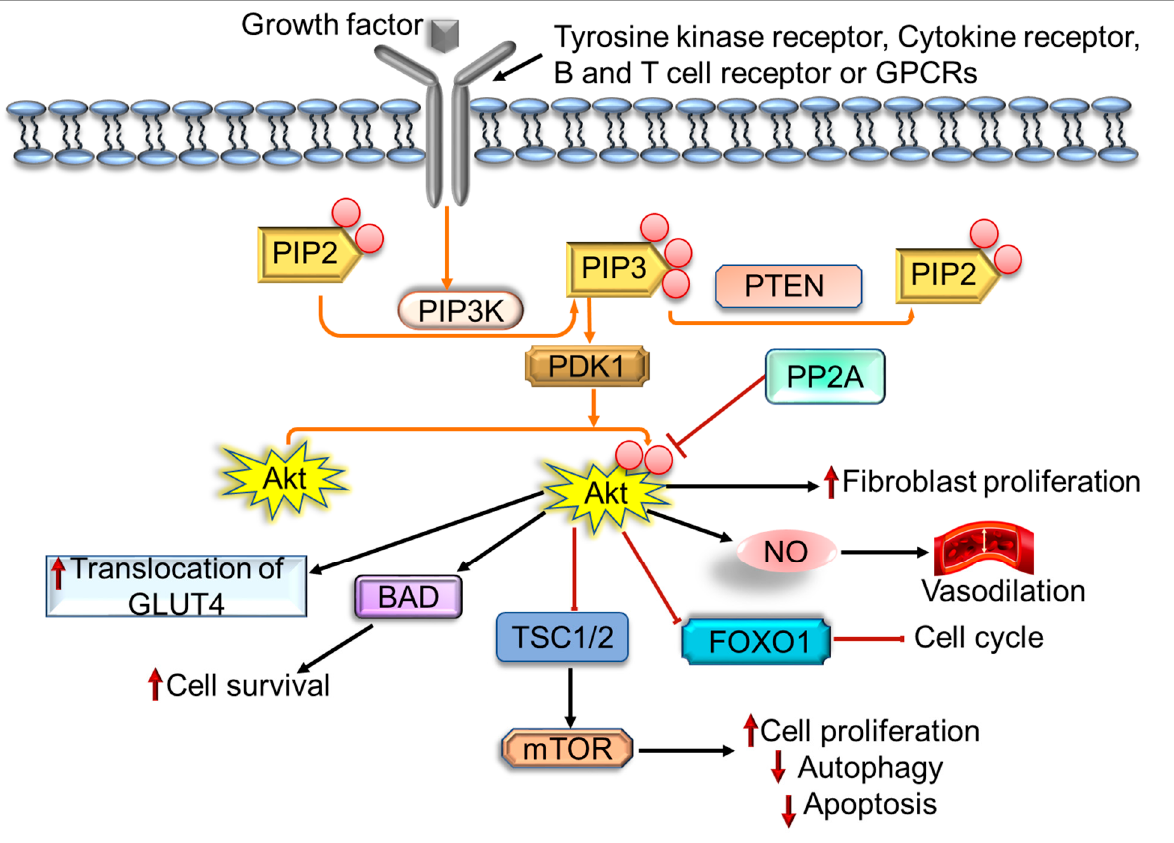
Figure 2. PI3K/Akt signaling pathway; PIP2, phosphatidylinositol 4, 5-bisphosphate; PTEN, phosphatase and tensin homolog deleted on chromosome 10; PDK1, 3-phosphoinositide-dependent kinase 1; PP2A, protein phosphatase 2A; BAD, BCL2 associated agonist of cell death; GLUT4, glucose transporter type 4; GPCRs, G-protein-coupled receptors; TSC, tuberous sclerosis complex; FOXO1, forkhead box O1 protein; NO, nitric oxide.